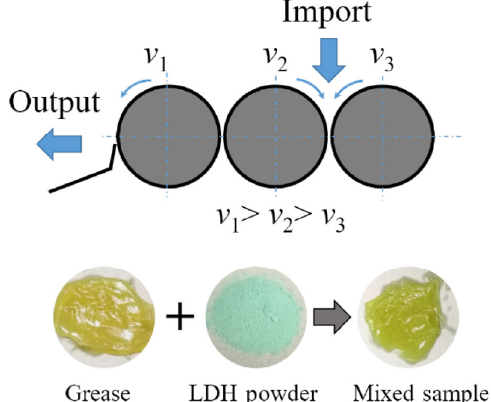
Fig. 1 Schematic diagram of grinder and the dispersion effect of LDH powder in